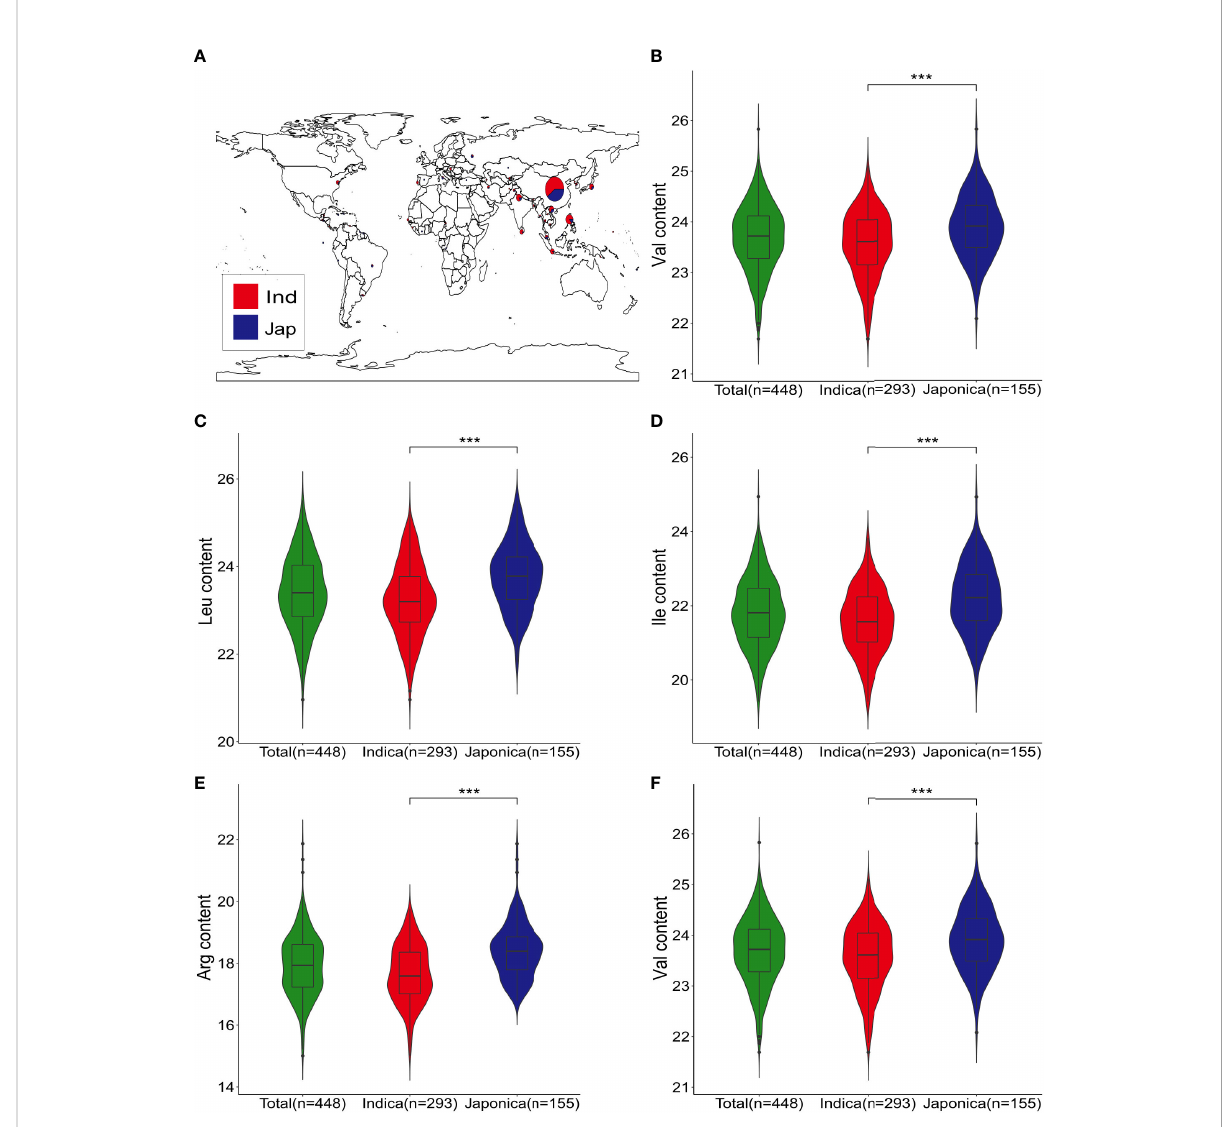
FIGURE 1 Geographic distribution and fi ve FAA levels of genetic panel. (A) Geographic distribution of indica and japonica accessions in the genetic panel; indica accessions are indicated in red, and blue represents japionica accessions. (B – F) Violin plots of Val, Leu, Ile, Arg, and Trp contents for all, indica, and japonica accessions; *** indicate statistical signi fi cance at the 0.1% probability